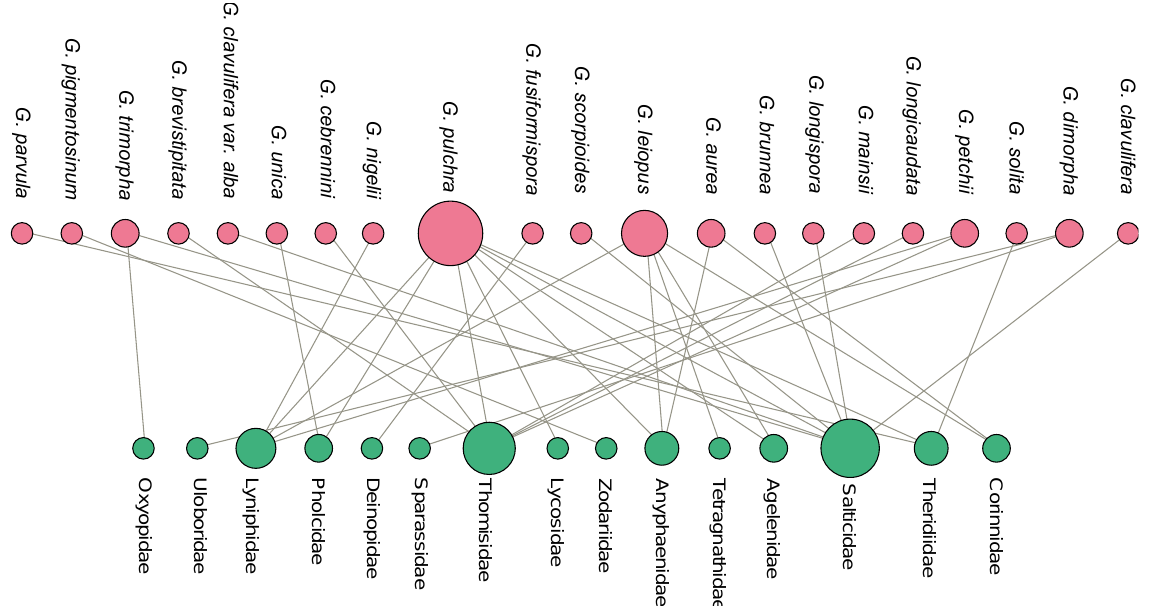
Figure 7. Bipartite network connecting the species of Gibellula (pink) and families of spiders (green) that were reported as hosts. Nodes (species/family) with higher numbers of connections are propor- tionally larger than the ones with fewer parasite–host associations.